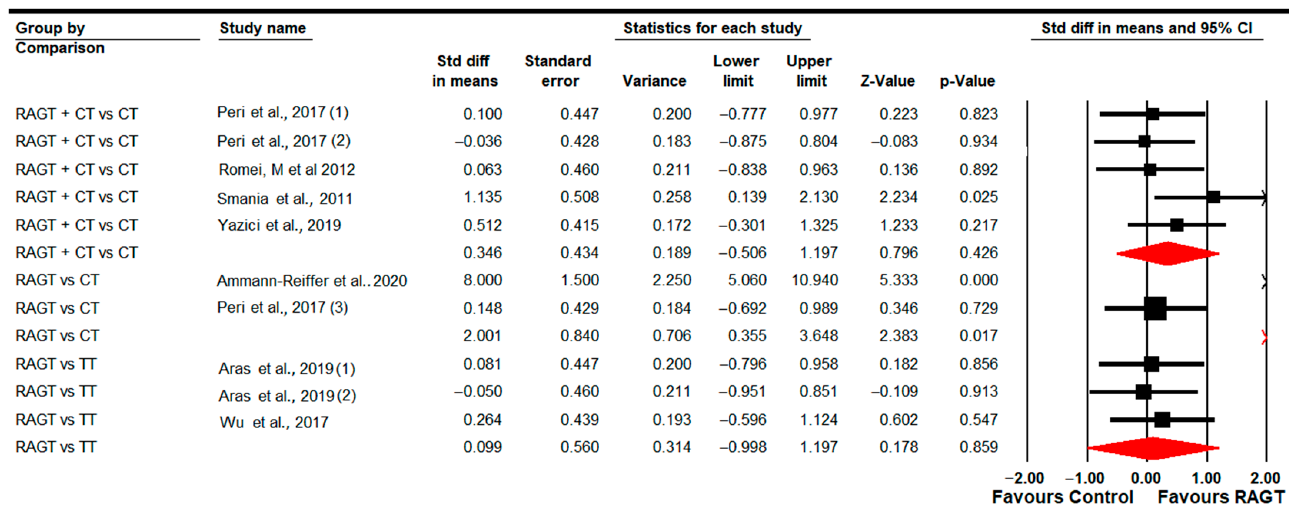
Figure 5. Forest Plot of Step width (Post-Intervention Assessment) [79].